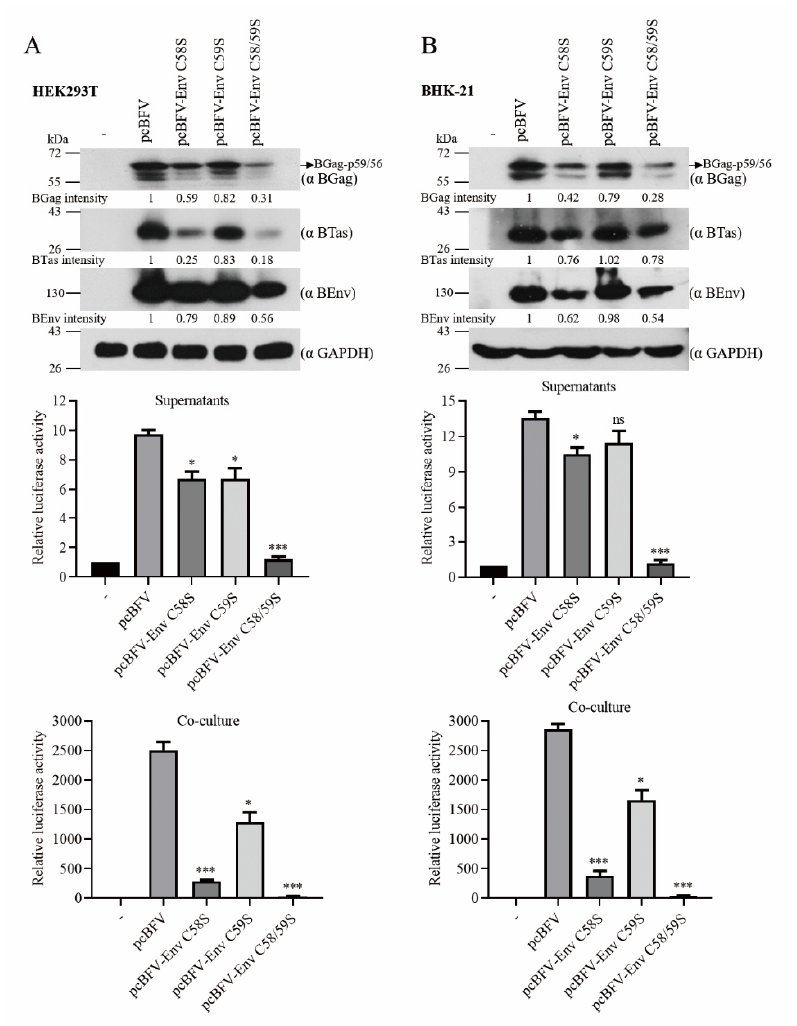
Figure 5. BEnv palmitoylation is required for BFV transmission. ( A ) HEK293T cells were transfected with an empty vector, wild type BFV infectious DNA clone pcBFV, or BFV infectious DNA clone with mutations in BEnv-palmitoylated cysteines (pcBFV-Env C58S, pcBFV-Env C59S, pcBFV-Env C58/59S). At 48 h post-transfection, culture supernatants or transfected 293T cells (1/20 of the total) were co-cultured with the BFVL indicator cell line for another 48 h and luciferase activity was measured (right). The data shown were the averages from three independent experiments; error bars represent the SD. p -values are indicated as follows: * p < 0.05, *** p < 0.0001, and ns for p > 0.05. The rest of the transfected cells were subjected to Western blotting with the indicated antibodies (left). The indicated band intensities were quantified with Image J. ( B ) Same as in A, except that it was performed in BHK-21 cells.